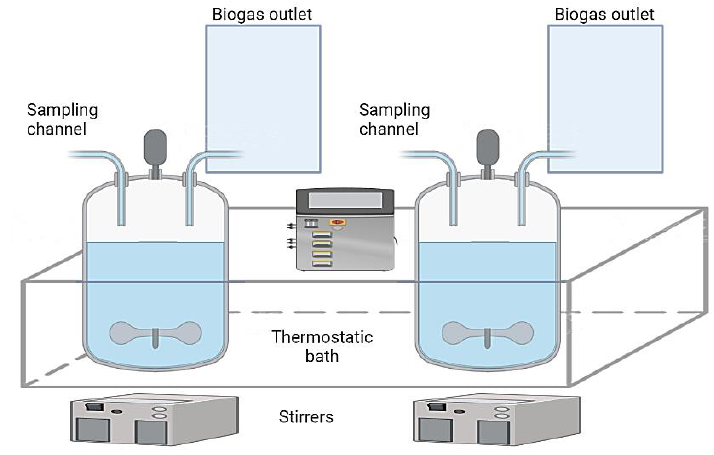
Figure 8. Scheme of the experimental setup for the AD. Table 3. Description of the experimental setup.